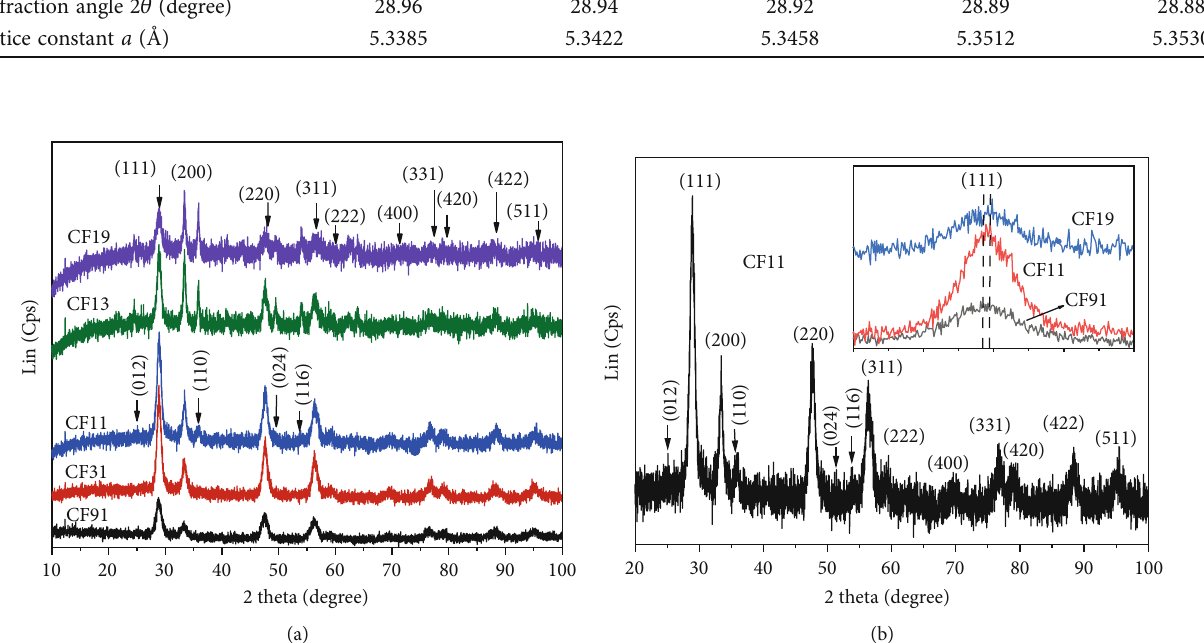
Figure 3: XRD pattern of CeO and CF650 sample was redrawn Table 1: 2 θ di ff raction angle and a lattice constant of CeO Sample